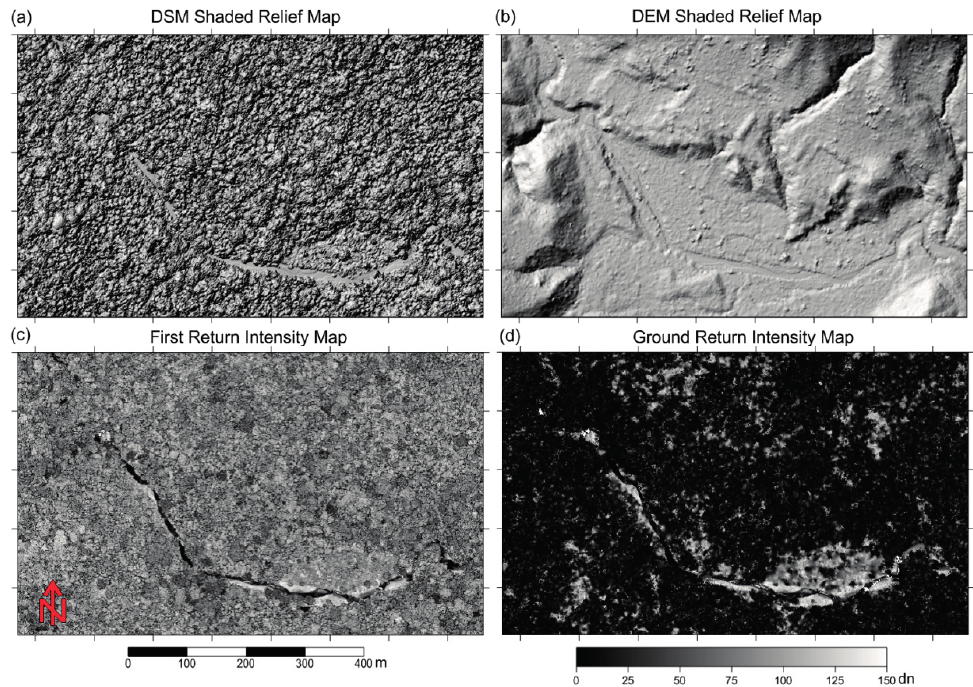
from the top of canopy and ground surface. ( a ) Shaded relief map from DSM; ( b ) shaded relief map from DEM; ( c ) intensity image produced from first returns only; ( d ) intensity image produced from ground returns